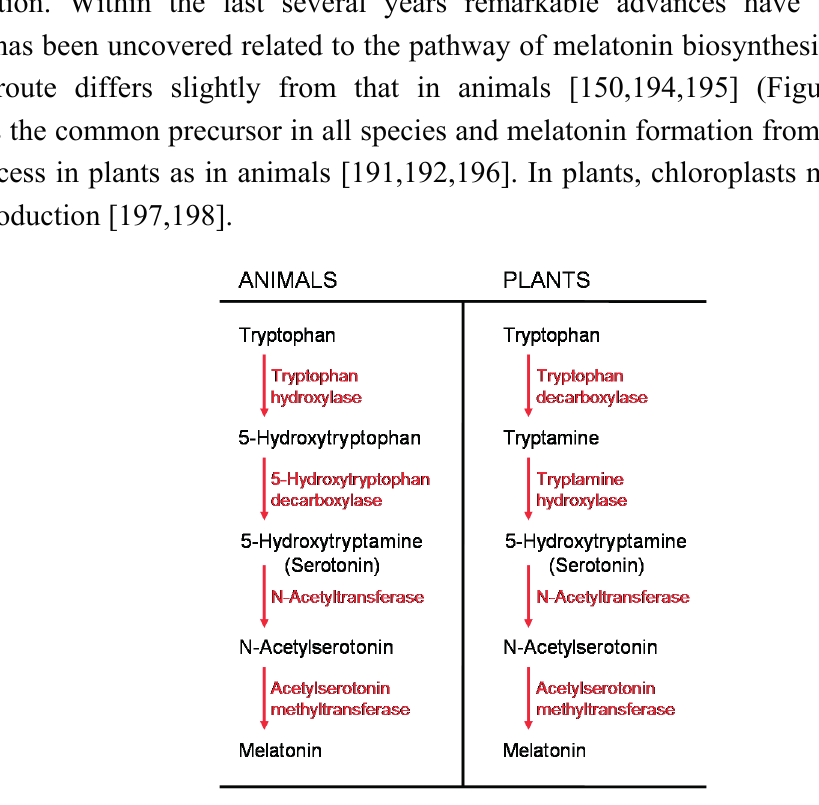
Figure 11. Pathways of melatonin synthesis from tryptophan in animals and plants.